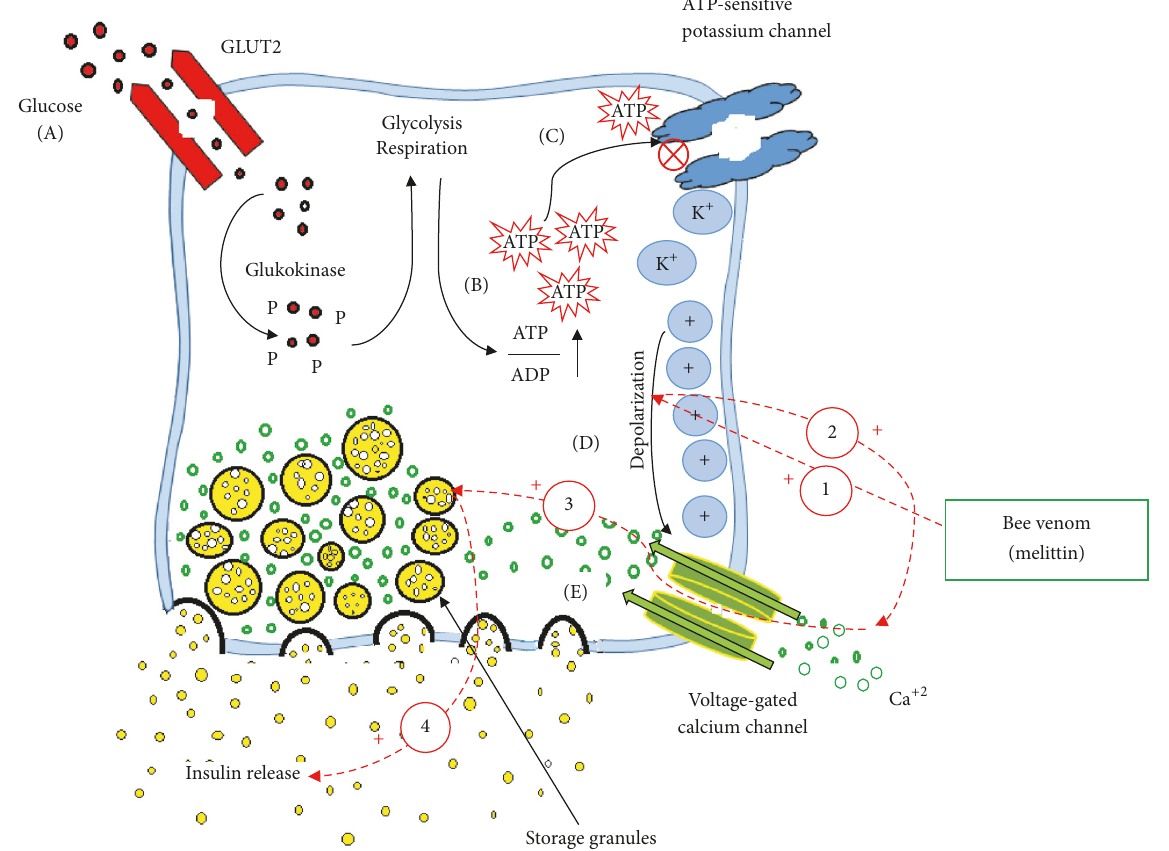
Figure1:BasicmechanismofinsulinsecretionandsequentialmechanisticpathwayofBV(melittin)leadingtoanincreaseininsulinsecretion in pancreatic 𝛽 -cells. (A) Blood glucose ( > 5 mM in concentration) enters the 𝛽 -cell through the glucose transporter (GLUT2). (B) ATP production rapidly occurs as a result of glycolysis and respiration. (C) Then, ATP-sensitive K + channels are closed, and K + efflux is inhibited. (D) Consequently, plasma membrane depolarizes, and (E) voltage-gated Ca 2+ channels open. Finally, Ca 2+ influx increases, which triggers exocytosis of insulin granules. A Melittin directly depolarizes the cell membrane, B it increases Ca 2+ inflow into the cell, C it promotes more granule secretion, and D it increases insulin secretion into the blood stream. Note: phosphorus: P; calcium: Ca 2+ . Adapted